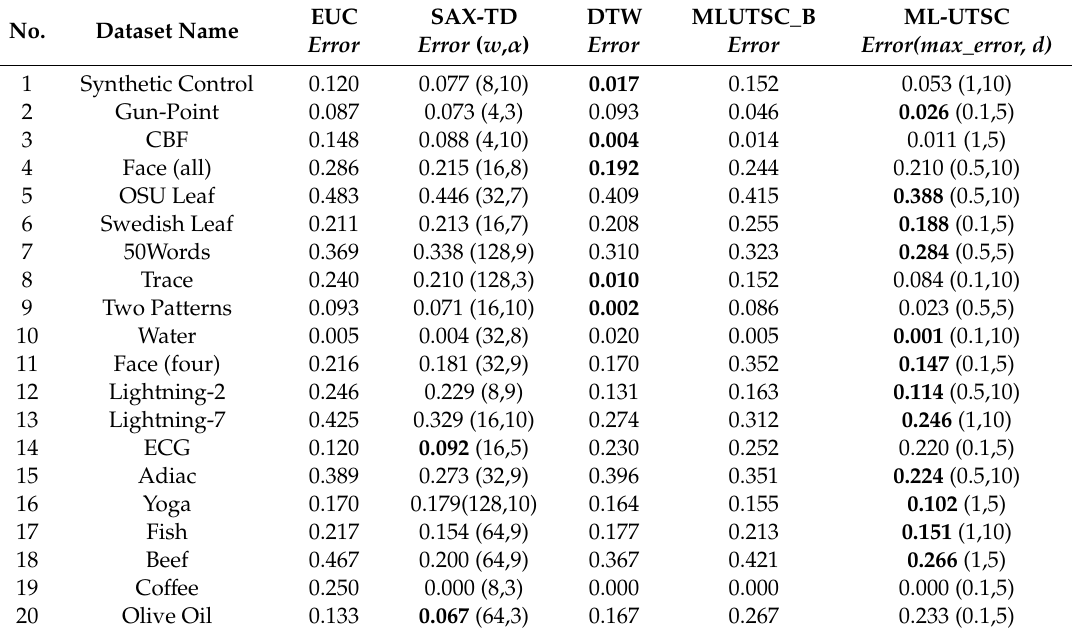
Table 2. Comparision of parameters for the five algorithms